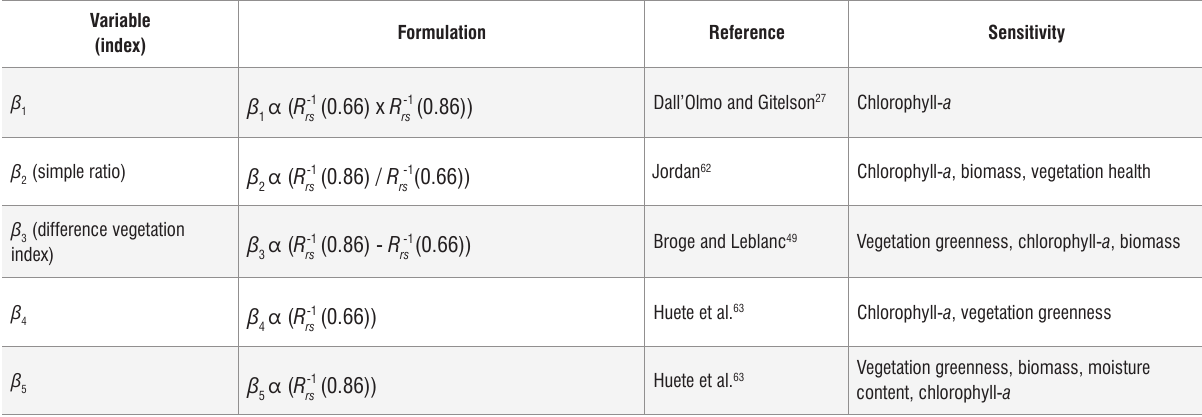
The input remote sensing variables used for estimating chl- a Variable (index)